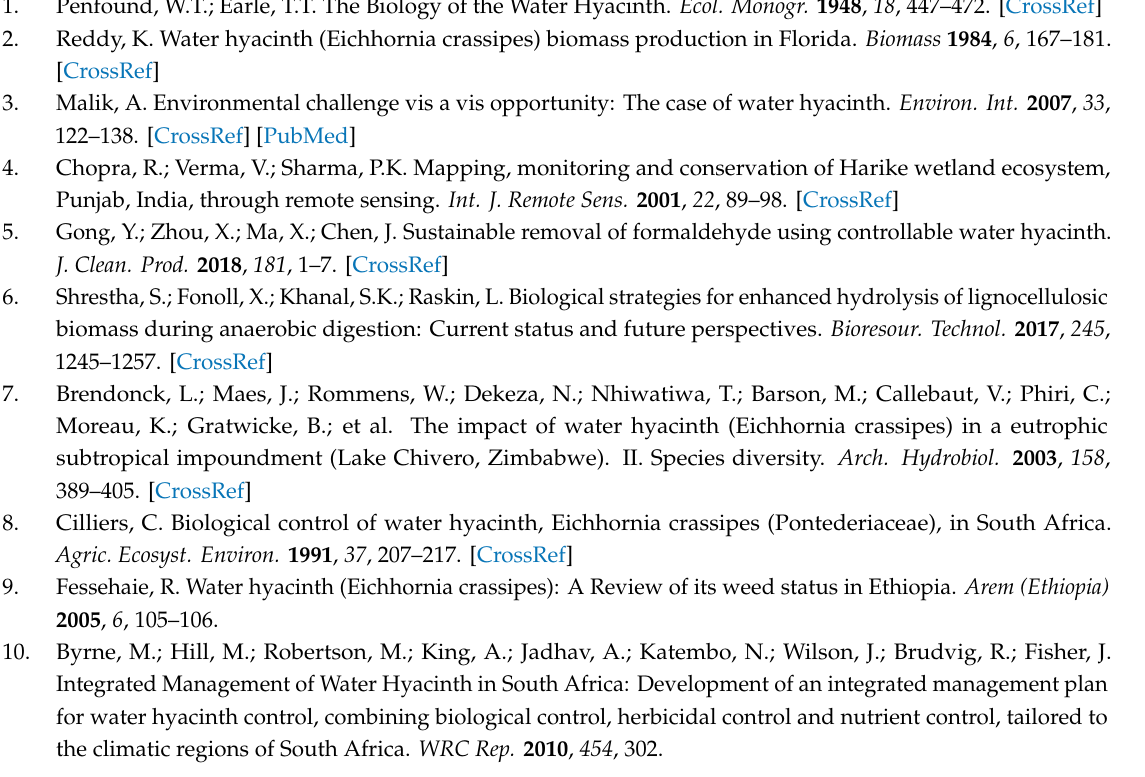
Figure S1: GPS tracks of June 25, 2017, overlain on a false-color composite image of June 24, 2017, PlanerScope, Table S1: List of satellite images used to map the spatiotemporal distribution of water hyacinth and major environmental factors plausibly a ff ecting the weed spatial